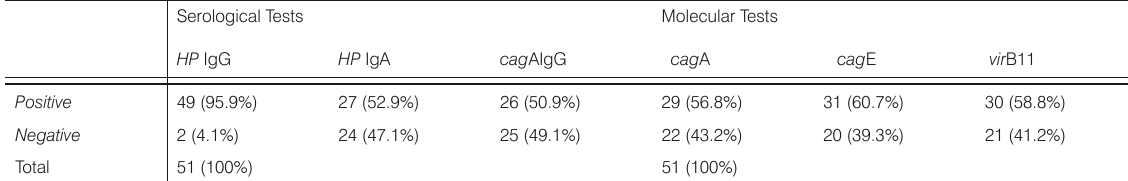
Table 2. Results of PCR for cag A, cag E and vir B11 regions and serological tests from patients with HP